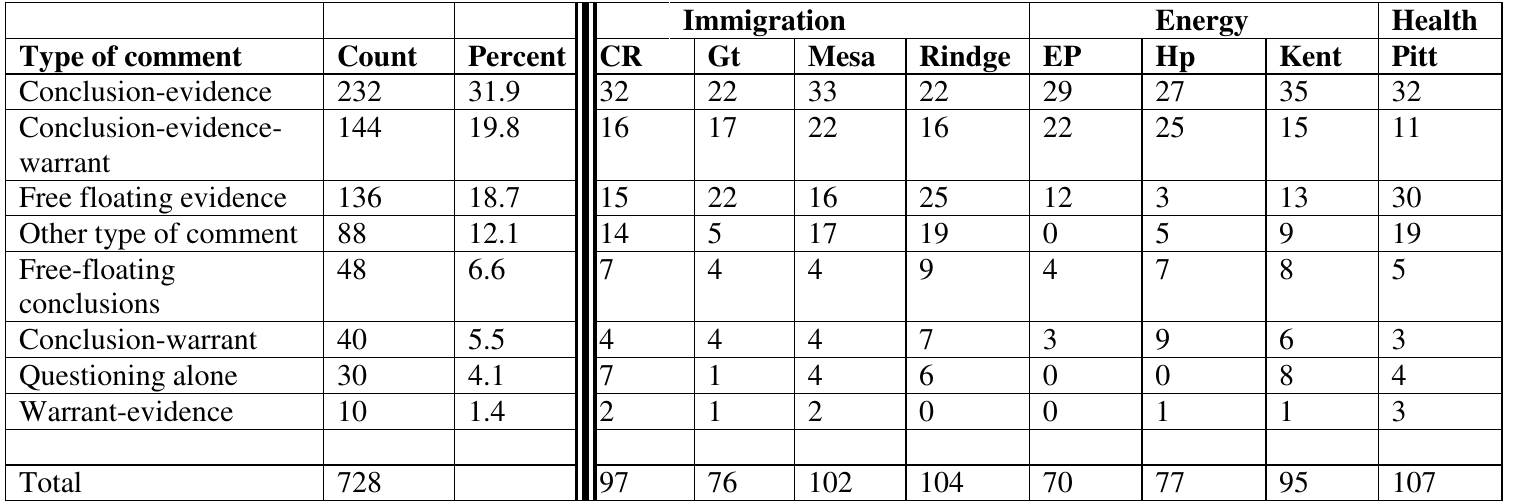
Table 3: Deliberator Complete Comments by